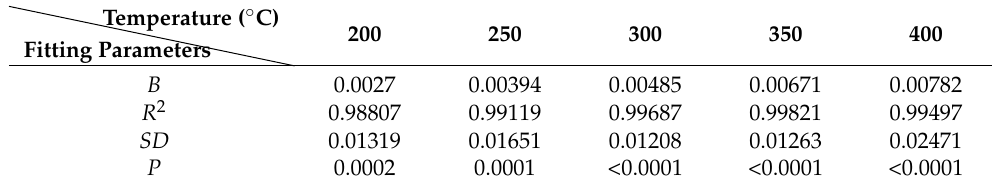
2 (cid:3118) 3 + 2 ( 1 − X ) and t . (cid:3119) (cid:3397) 2(cid:4666)1 (cid:3398) (cid:1850)(cid:4667) and t . 2 3 + 2 ( 1 − X ) vs. t . (cid:3118) (cid:3119) (cid:3397) 2(cid:4666)1 (cid:3398) (cid:1850)(cid:4667) vs. t .